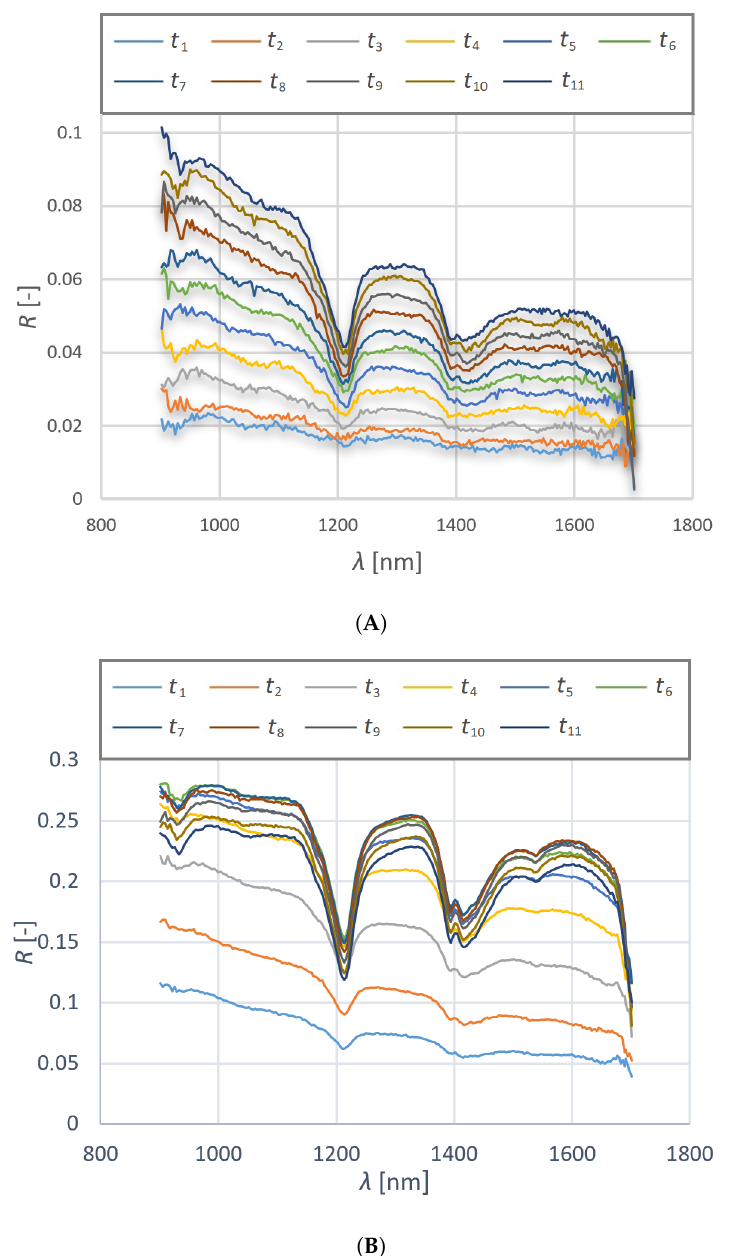
Figure 2. Reflectance spectra of two wax materials: ( A )—paraffin, ( B